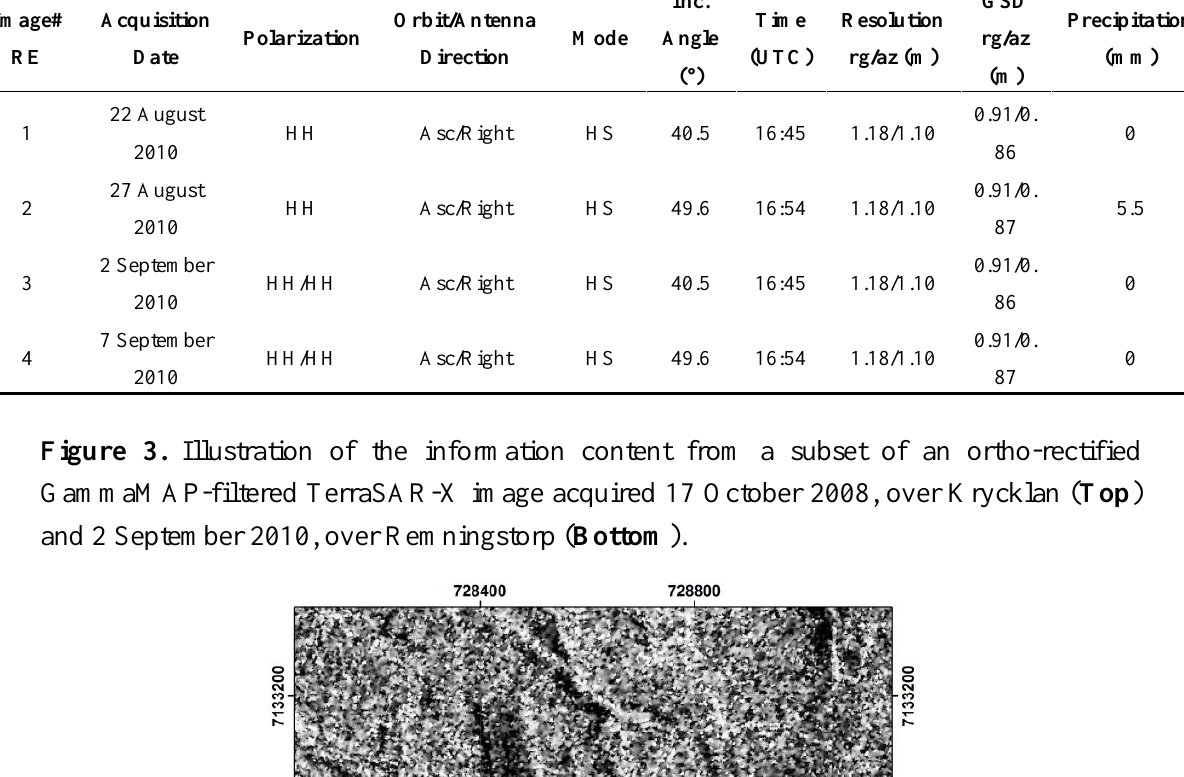
Table 3. The list of TerraSAR-X satellite images used for the Remningstorp (RE) test site. Image#